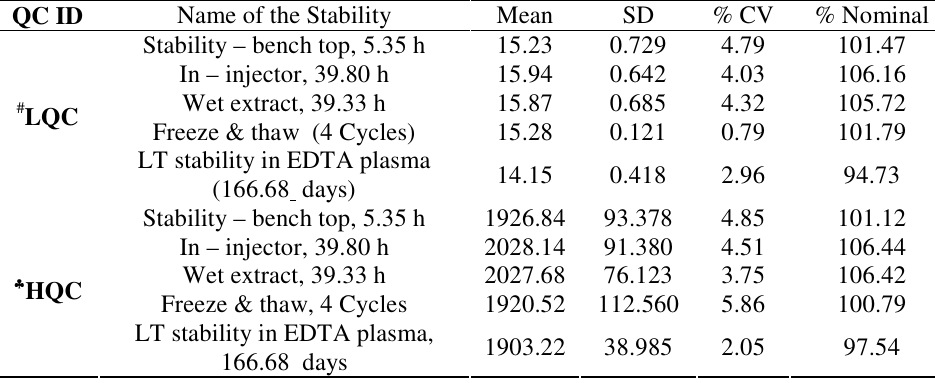
Table 3. Stability data of quality controls in human EDTA plasma